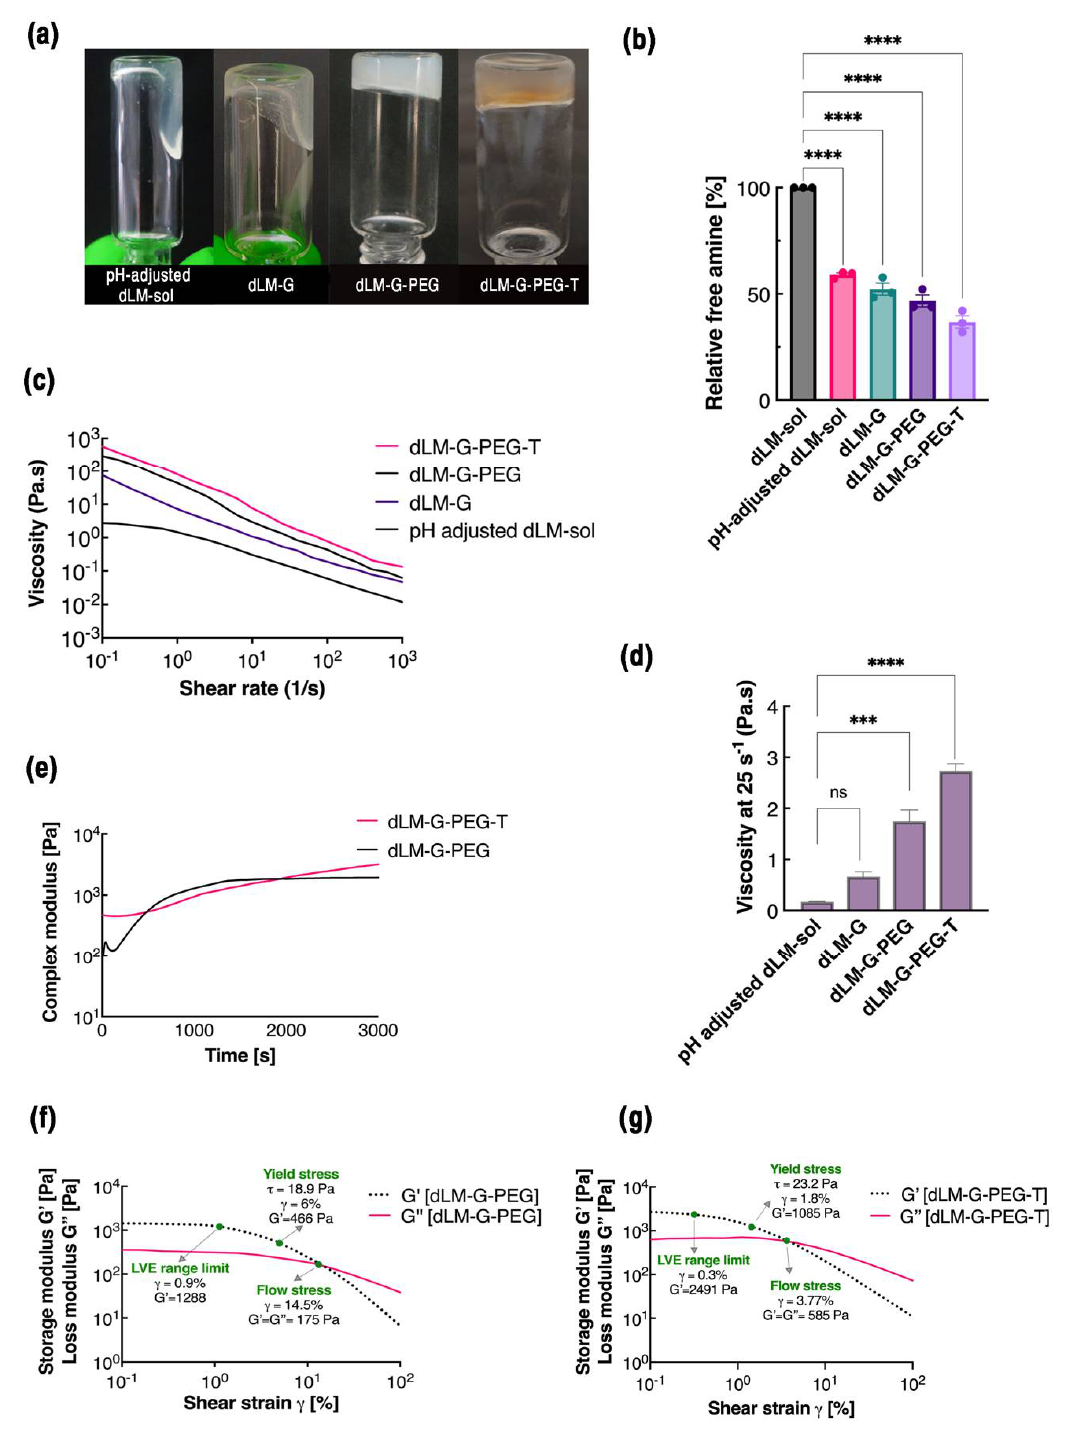
Figure 3. Characterization of dLM formulations ( a ) visually for pH-adjusted dLM-sol, dLM-G, dLM-G-PEG bioink, and dLM-G-PEG-T at 37 °C and ( b ) TNBS assay with decreasing free amines relative to dLM-sol (**** p < 0.0001) Rheological properties at 37 °C with ( c ) viscosity at increasing shear rates and ( d ) comparison of viscosities of different formulations at 25 s –1 (*** p < 0.001 and **** p < 0.0001). ( e ) Gelation kinetics of dLM-G-PEG bioink and dLM-G-PEG-T. Oscillatory amplitude sweep analyzed at 1 Hz angular frequency to estimate the mean yield stress (n = 3), linear viscoelastic (LVE) range, and flow stress to analyze storage (G’) and loss (G”) modulus from 0.1 to 100% strain for ( f ) dLM-G-PEG and ( g )